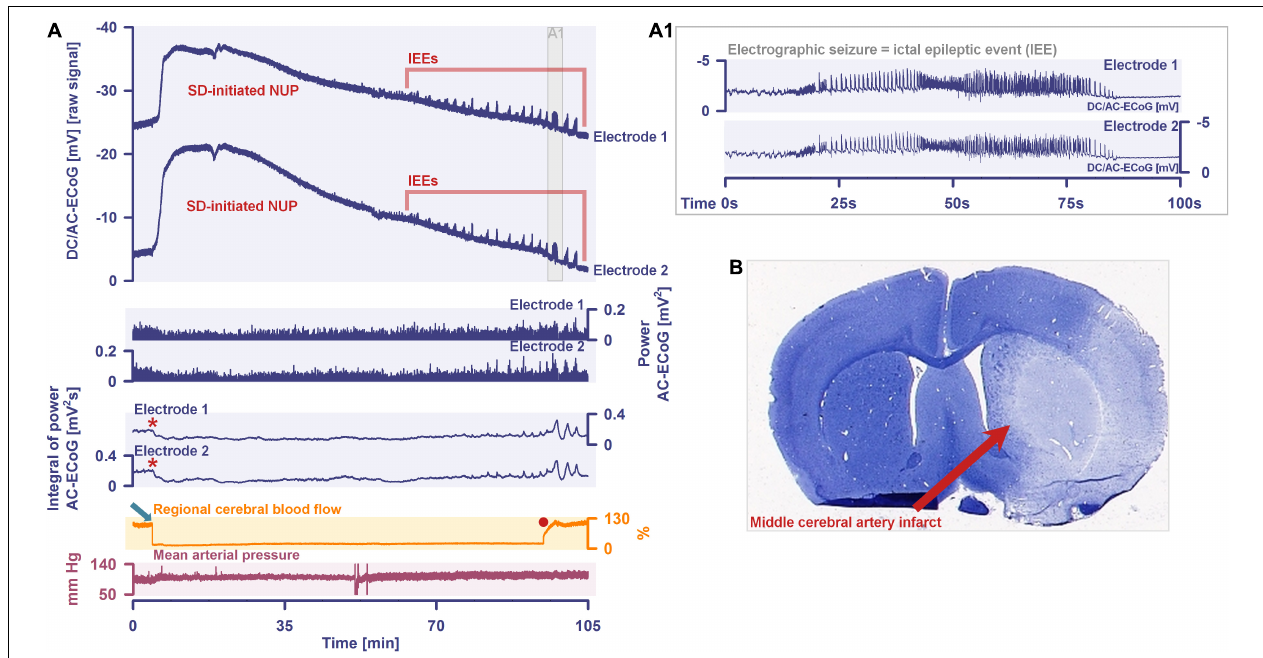
FIGURE 4 | (A) Spreading depolarization-initiated NUP with superimposed ictal epileptic events (IEEs) after middle cerebral artery occlusion (MCAO) in a rat (Luckl et al., 2018). Traces 1 and 2 show the full-band ECoG signal [DC/AC-ECoG] which contains both the negative DC shifts that identify spreading depolarizations and the changes in spontaneous brain activity. Traces 3 and 4 only show the spontaneous activity in the higher frequency band (AC-ECoG, bandpass: 0.5–45 Hz). Traces 5 and 6 display the integral of the power of the AC-ECoG which provides a smoothed curve easing visual assessment of changes in AC-ECoG power. Trace 8: regional cerebral blood flow (rCBF) recorded with laser-Doppler flowmetry. Trace 9: mean arterial pressure measured via femoral artery catheter. MCAO leads to a sharp decrease in rCBF (dark green arrow in trace 7). Shortly after MCAO, non-spreading depression of activity occurs and is best observable in the integral of the power (red asterisks at traces 5 and 6). The drop in rCBF triggers a spreading depolarization that propagates from electrode 2–1 and initiates a NUP (traces 1 and 2). Electrographic seizures, also known as IEE, occur superimposed on the NUP. They continue and even intensify after the reperfusion (red dot at trace 7). (A1) Displays one of the IEEs at higher temporal resolution. (B) The animal was sacrificed 72 h later. The infarct in both basal ganglia and cortex is macroscopically identified as a pale area using hematoxylin staining.